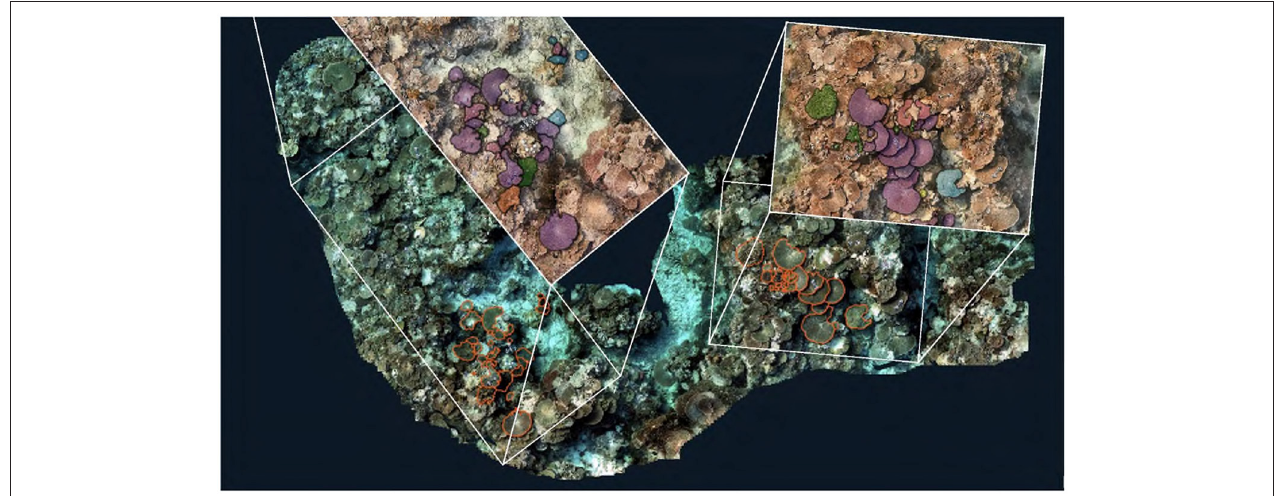
FIGURE 1 | Example of two datasets collected with different platforms over the same area of a coral reef. The larger dataset was collected using action cameras and has a ground sampling distance of approximately 1cm, the smaller excerpts were collected with a digital single-lens reflex camera and has a ground sampling distance of approximately